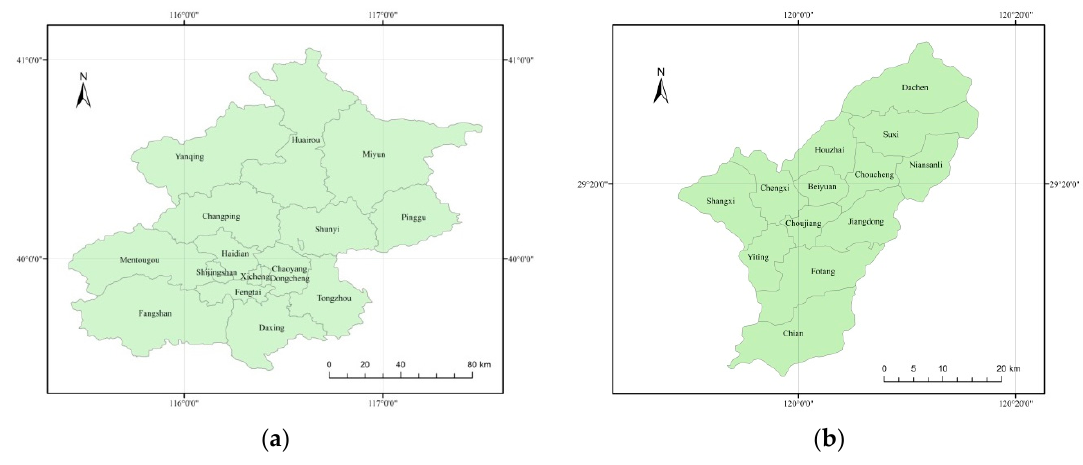
Figure 1. Division of Beijing ( a ) and Yiwu ( b ).